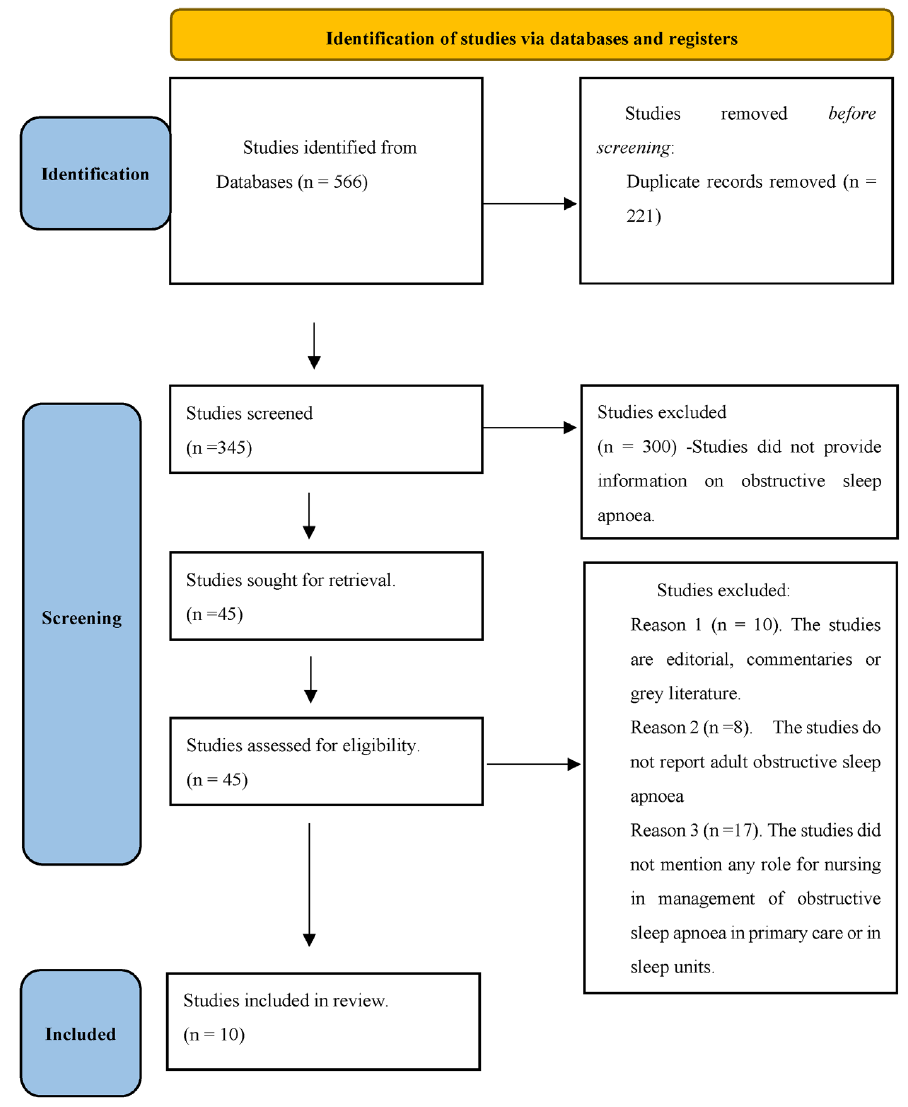
Figure 1. PRISMA Flow Chart.